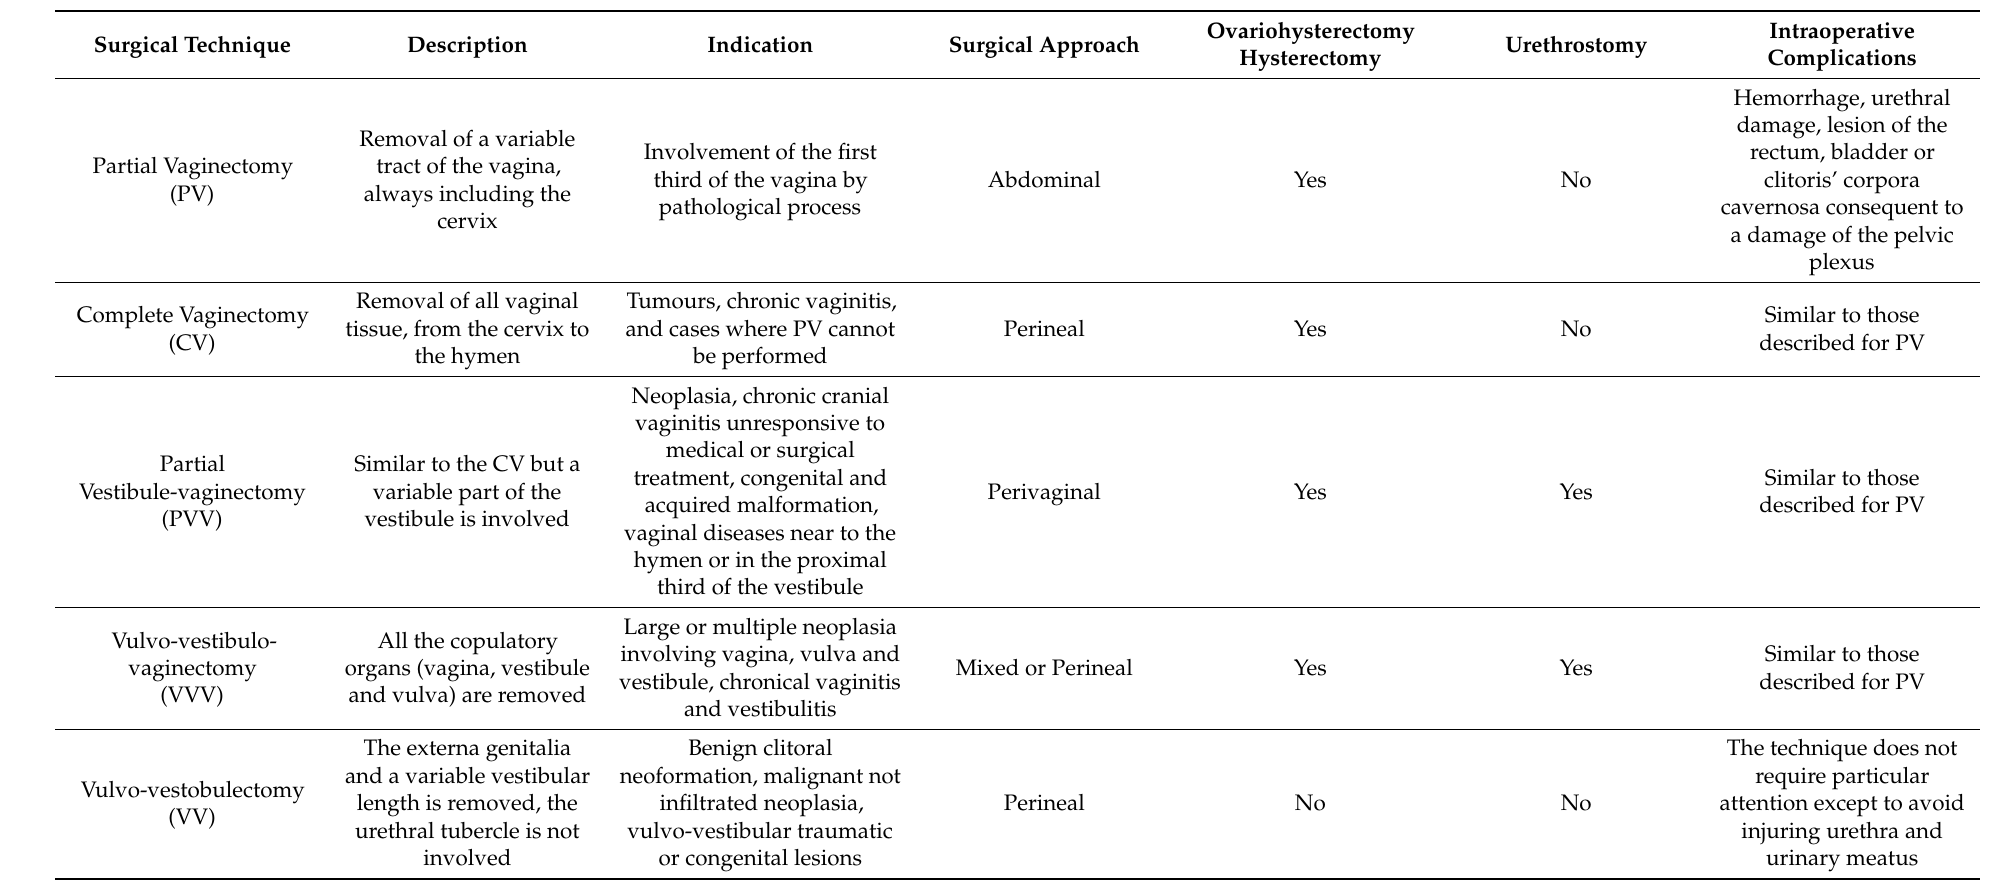
Table 1. Principle information about the five surgical techniques described in the